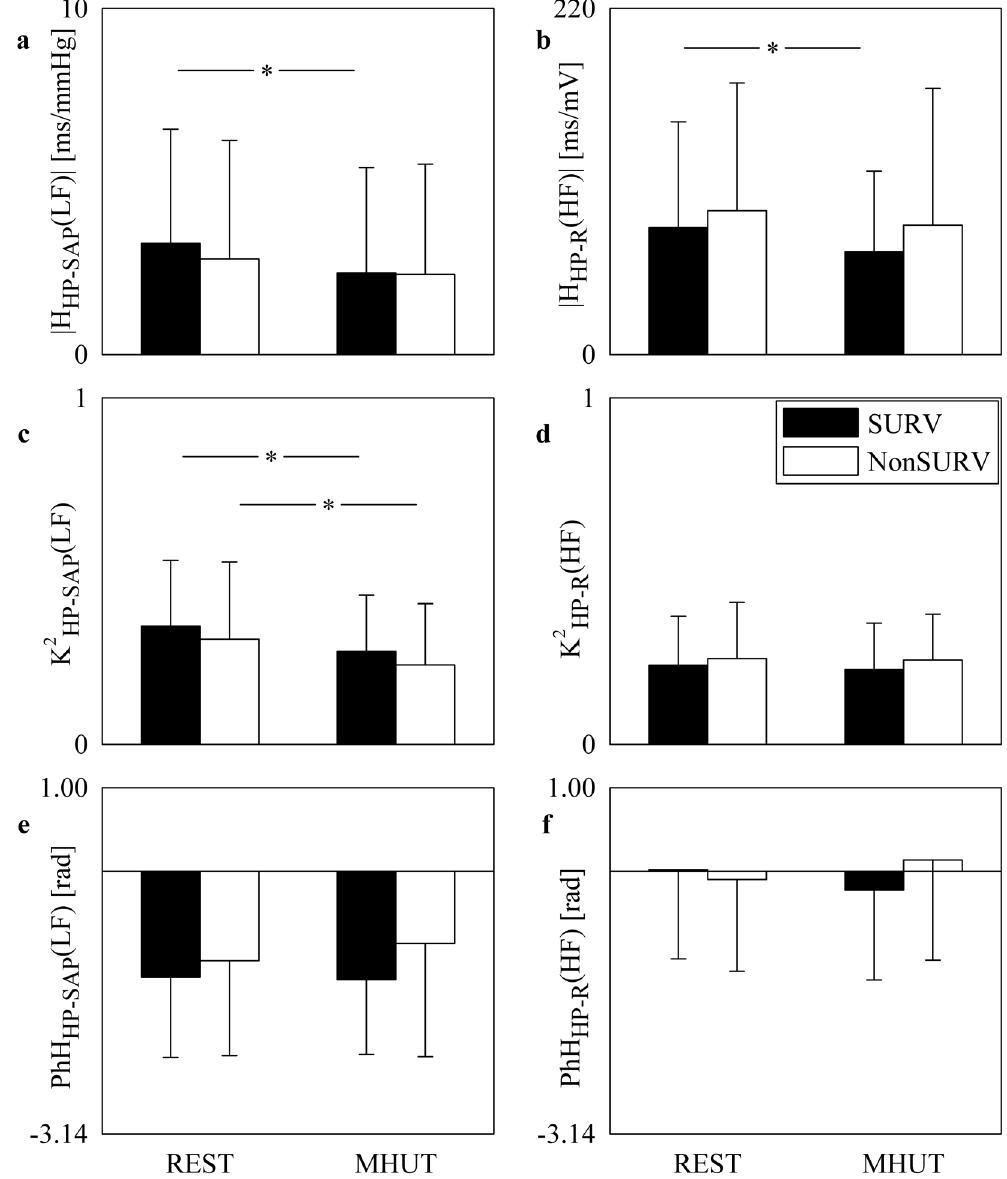
Figure 4. The bar graphs show |H HP-SAP (LF)| ( a ), |H HP-R (HF)| ( b ), K 2 HP-SAP (LF) ( c ), K 2 HP-R (HF) ( d ), PhH HP- SAP (LF) ( e ), and PhH HP-R (HF) ( f ) as a function of the experimental condition (i.e. REST and MHUT) in SURVs (dark bar) and NonSURVs (white bar). Data are reported as mean plus standard deviation. The symbol * indicates p <